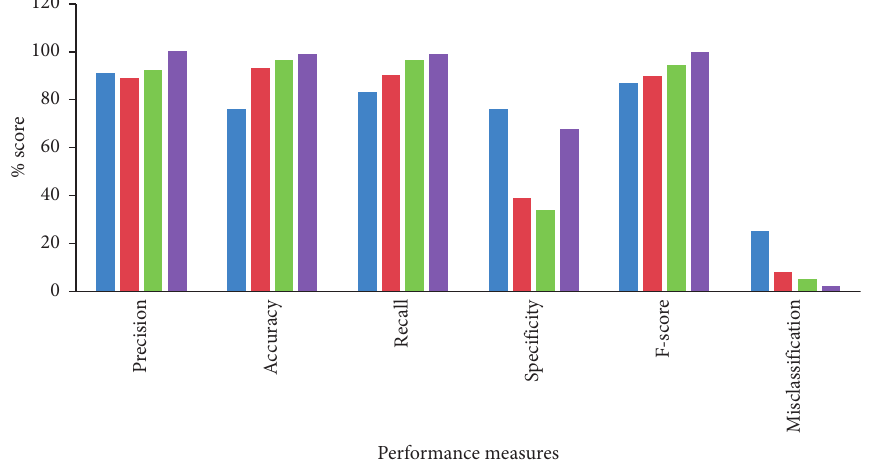
Figure 5: KNN-based performance results.